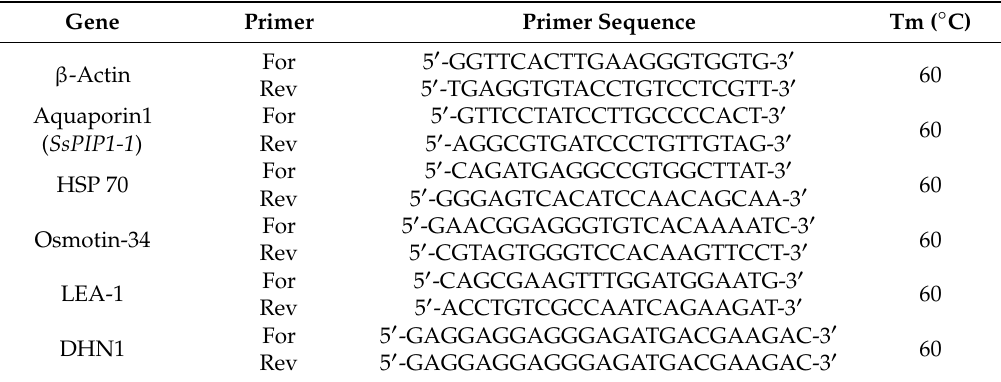
Table 2. The sequences of the primers used in